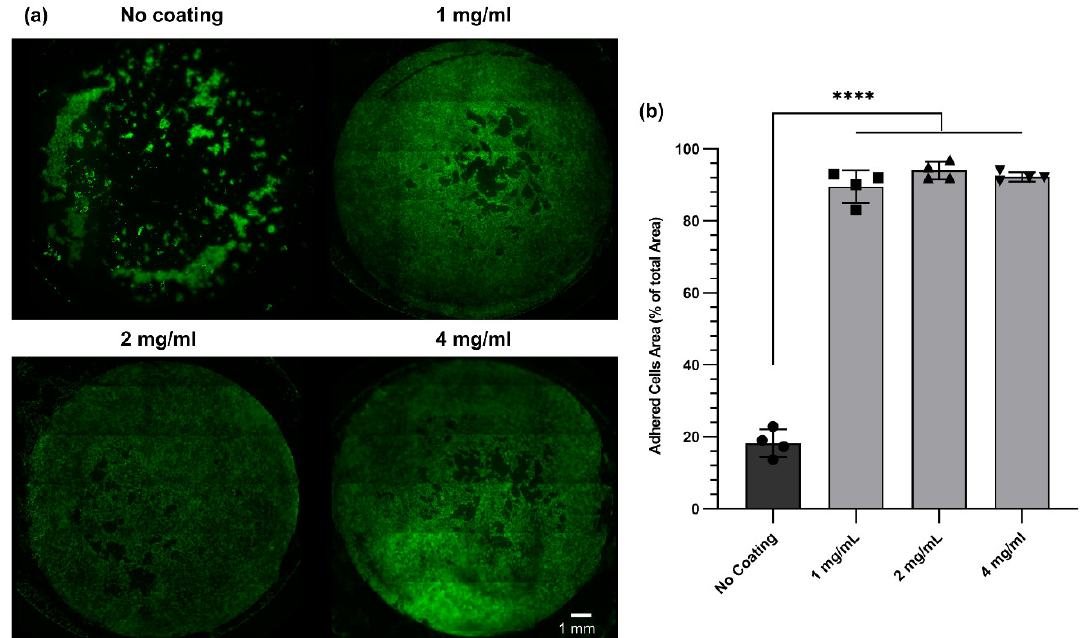
Figure 7. Viability assays of human bronchial epithelial cells cultured for 7 days on dECM-coated polyethersulfone (PES) membranes. ( a ) Viability images of the cells for non-coated and coated membranes. ( b ) The adhered cells’ area as a percentage of the total surface area of the membrane (diameter of PES membranes was 13 mm) was evaluated using fluorescence microscopy images and analyzed in ImageJ software. **** p ≤ 0.0001